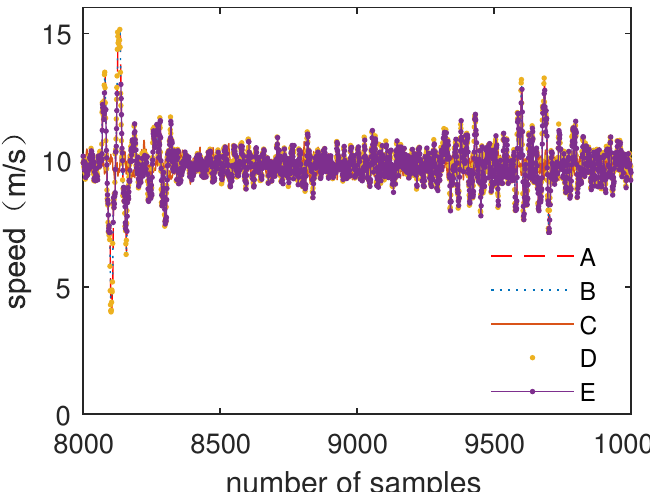
Figure 11. The comparison of speed data and data fusion.